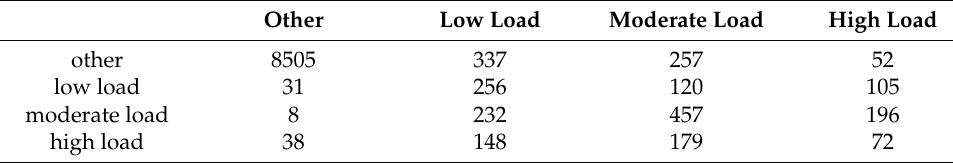
Table 1. Confusion matrix for the classifier’s performance on the test dataset.